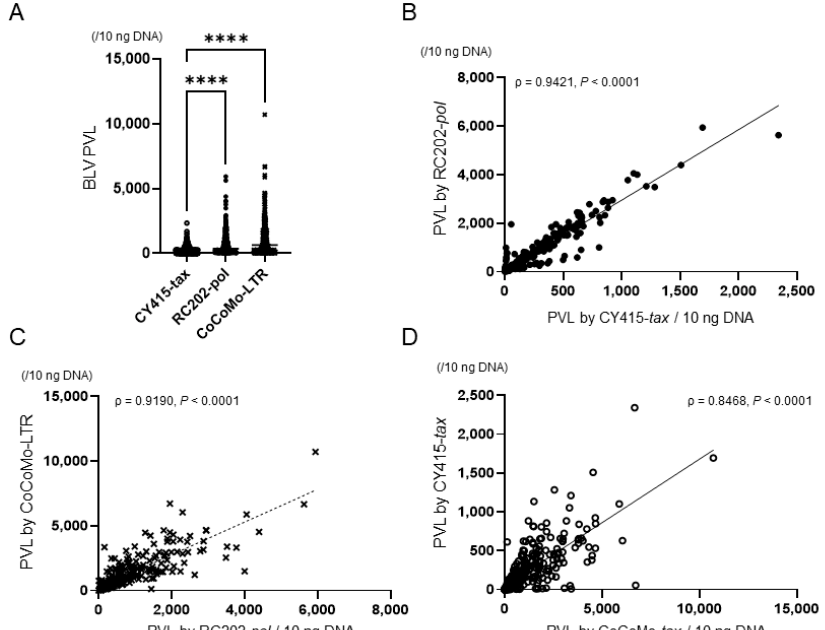
Figure 1. Bovine leukemia virus (BLV) proviral load (PVL) in whole-blood samples, as determined by different qPCRs. ( A ) BLV PVL. Differences between values obtained were assessed by using Kruskal-Wallis tests with Bonferroni’s multiple comparison as an ad hoc test. Horizontal bars indicate median values. ****, p < 0.0001. ( B – D ) Correlations between PVLs determined by each qPCR. Spearman’s correlation coefficient ( ρ ) and the levels of significance (P) regarding values are indicated in the graphs. Diagonal lines are regression lines.